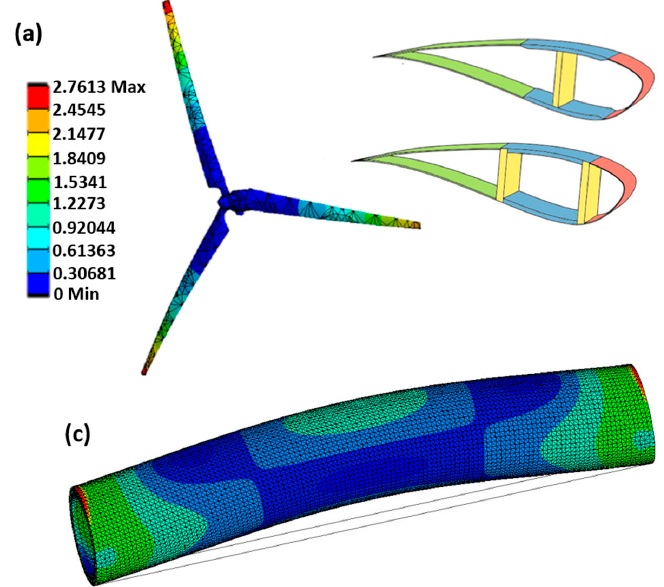
Figure 43. Some applications of FEM in composites for the energy sector: ( a ) wind turbines. Reproduced with permission [310] and ( b ) pipes for the oil and gas industry.